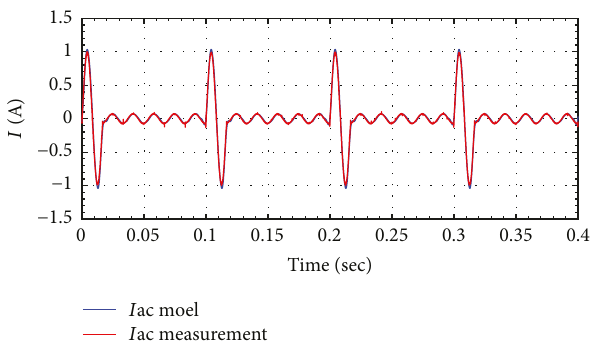
Figure 16: Output current waveforms of the microinverter and DDM during burst mode at the nontraining